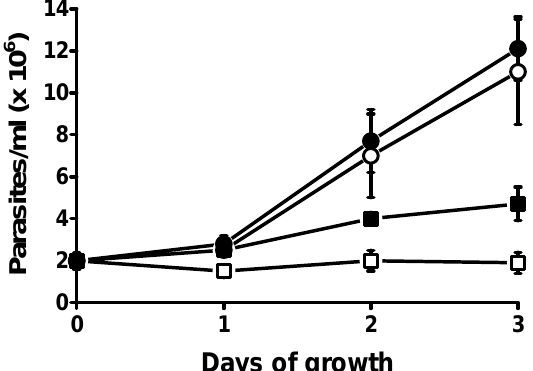
Figure 3. Effect of psilostachyin on the growth of T. cruzi in the presence of